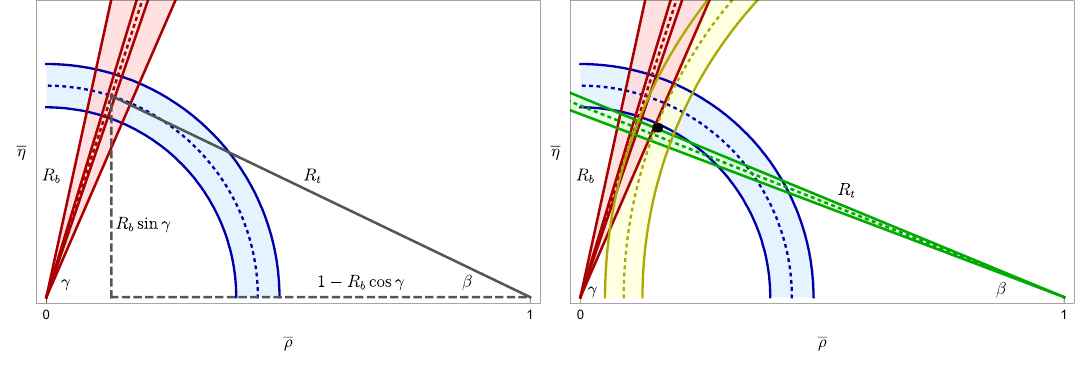
Figure 4 . Illustration of the Unitarity Triangle in the (cid:22) (cid:26) {(cid:22) (cid:17) plane. The left panel illustrates the determination of the side R t , where the blue circular band for R b corresponds to the average in eq. (3.24) and the wide red sector to the current value of (cid:13) in eq. (3.22); the narrow red sector illustrates the future improvement to 1 (cid:14) precision. In the right panel, we add constraints from (cid:1) M s = (cid:1) M d and CP violation in B 0 J= K S , and show the small black region for the d !